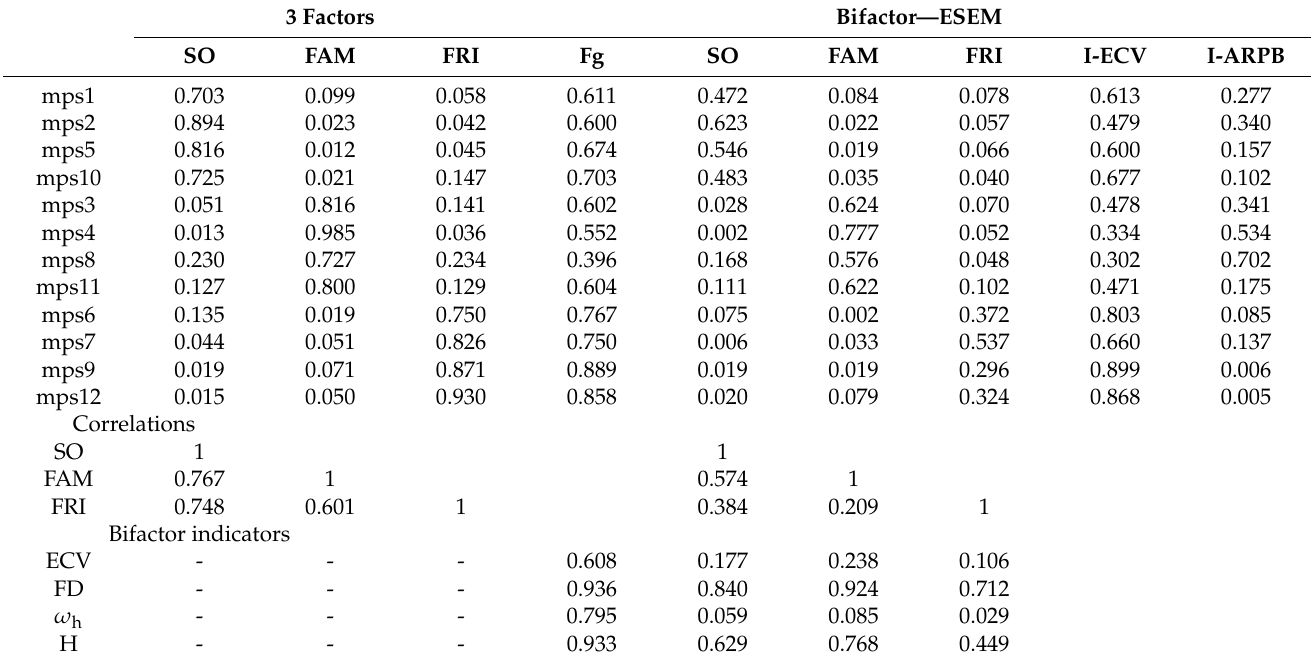
Table 5. Measurement models evaluated in the MSPSS using ESEM ( n =